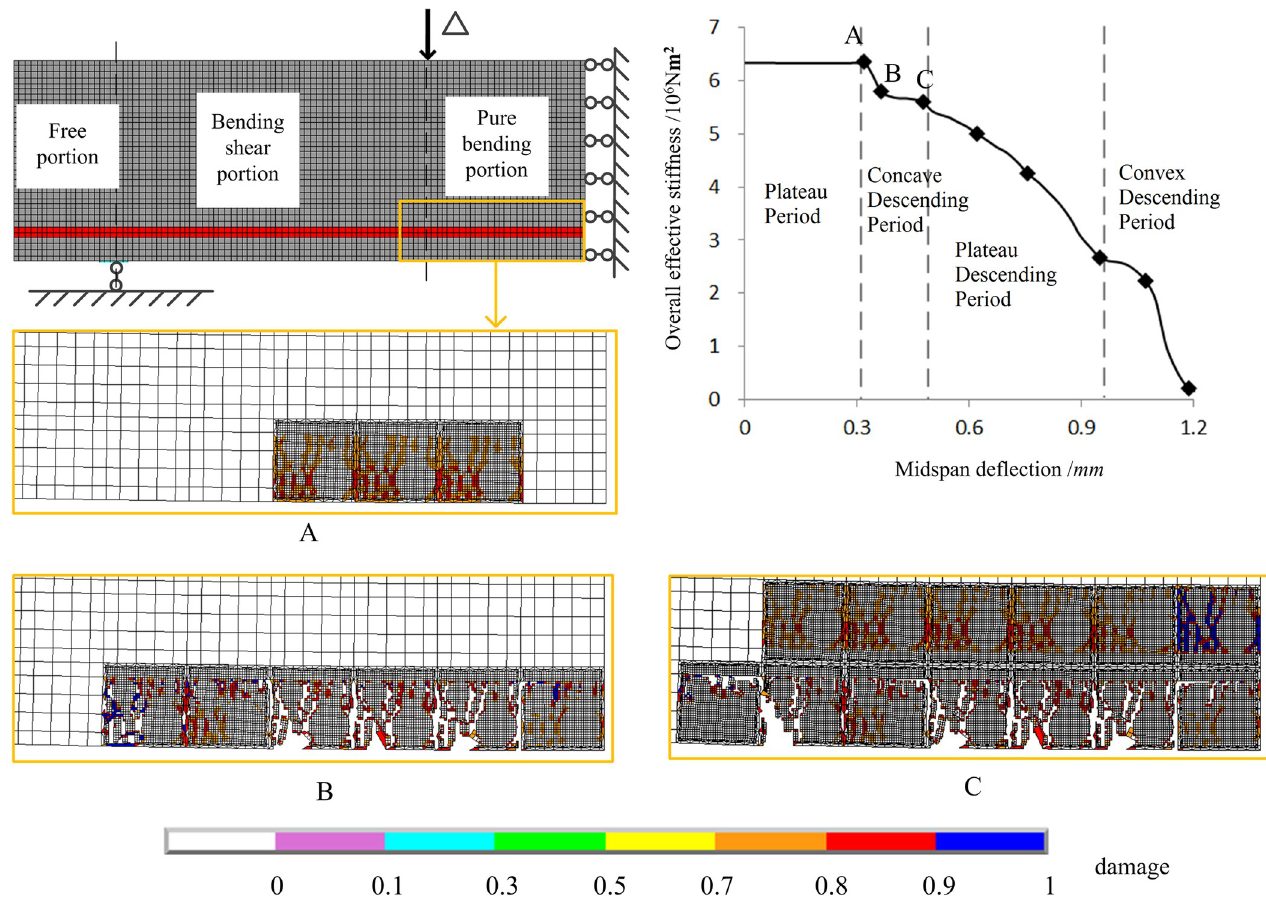
Fig 21. Three damage states in the concave descending portion of the overall effective stiffness. There are three damage states of A, B and C, which correspond to the points A, B and C that are located on concave descending period of the curve of overall effective